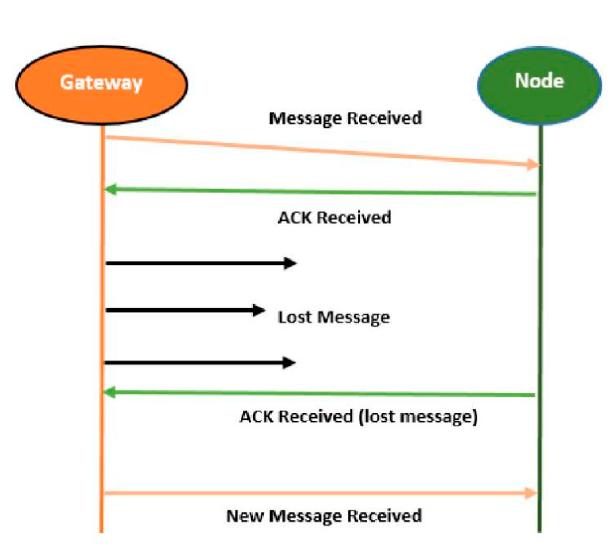
Figure 4. Failure of message integrity code.